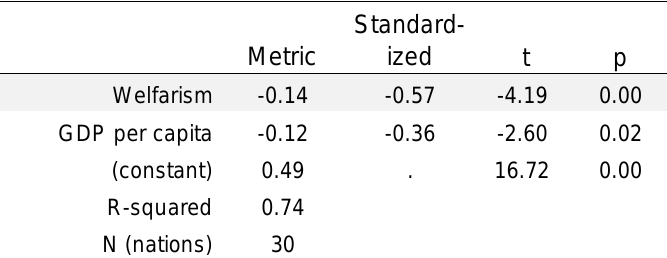
Figure 5. Inequality (measured by the Gini coefficient) as a function of welfarism and GDP. OLS regression coefficients. 30 nations, 1987–2009.